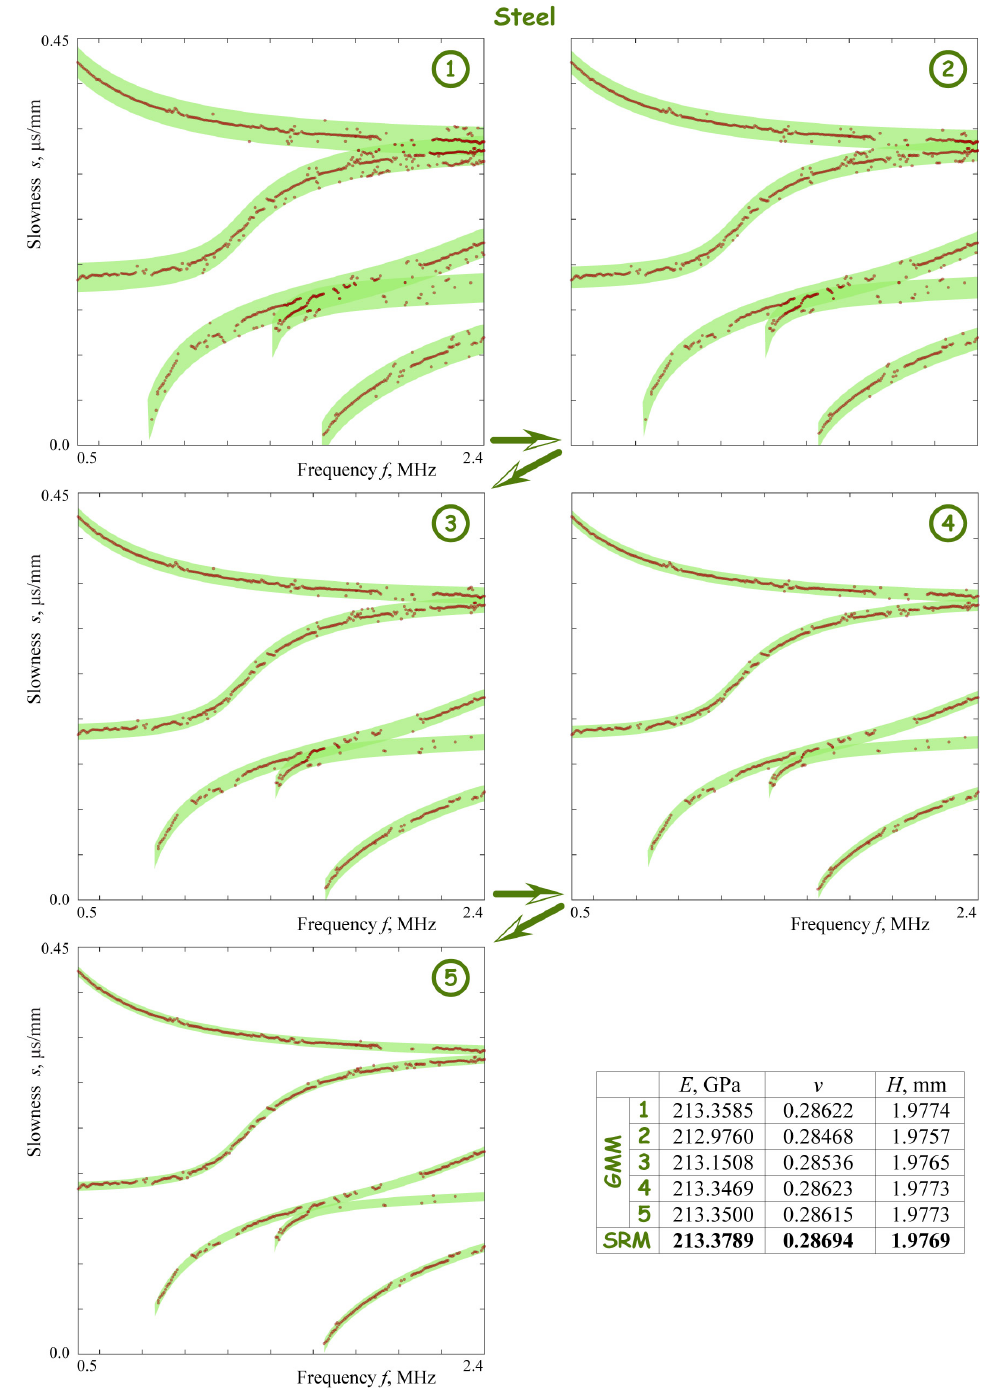
Figure 6. Experimental slownesses ˘ g ( j ) filtered during the iterative process of Step 2 for steel plate with the mass density ρ = 7843 kg/m 3 and thickness H = 1.975